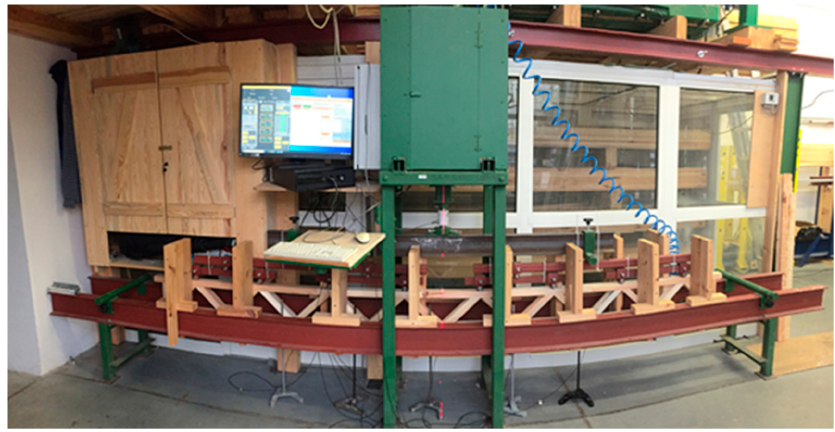
Figure 4. Picture of the test stand.